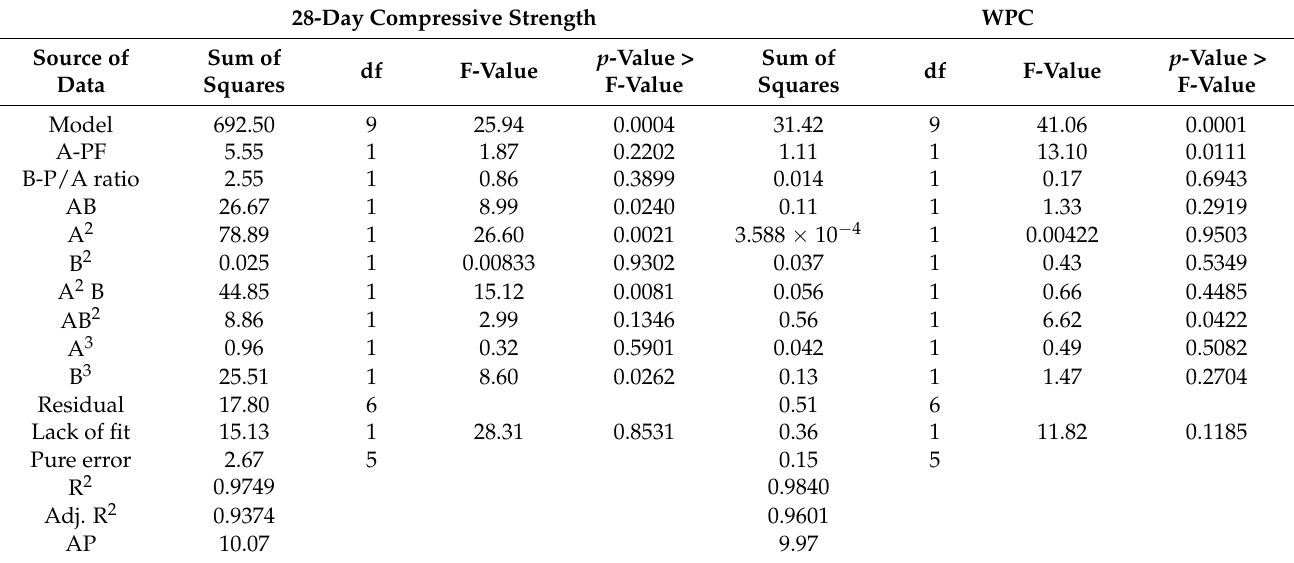
Table 5. ANOVA results for fitted numerical